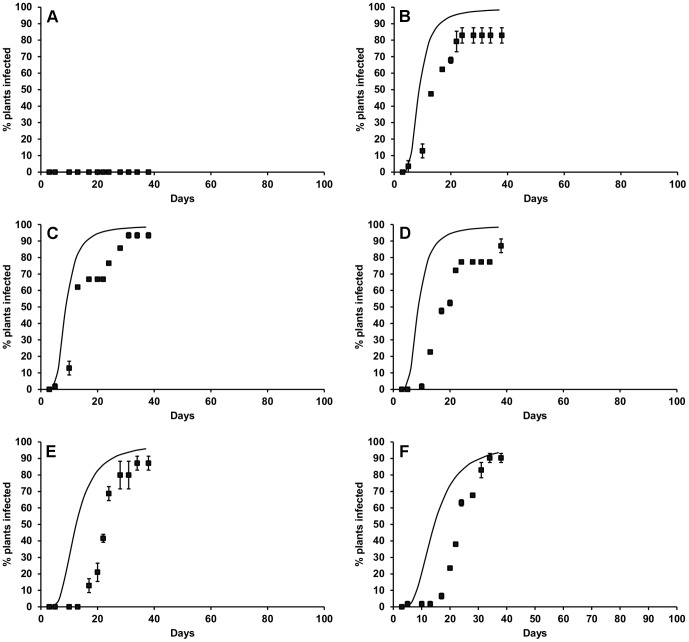
Observed and modelled S. sclerotiorum disease development in lettuce at A) 30°C (RMSE = N/A), B) 25°C (RMSE = 37.9), C) 20°C (RMSE = 29.0), D) 15°C (RMSE = 65.4), E) 10°C (RMSE = 48.2) and F) 7°C (RMSE = 27.3).Points represent observed data, lines represent model. Error bars are the standard error of the mean (three replicates).